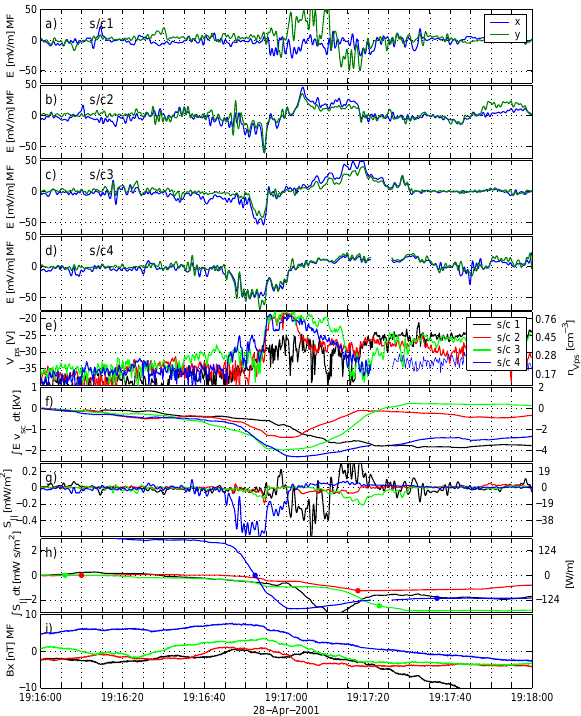
Fig. 24. Cluster overview plot from all four s/c from auroral arc crossing. (a–d) Electric field in mean field coordinates; x is pole- ward and y is eastward. (e) Probe to spacecraft potential and de- rived density estimate. (f) Integrated potential, the labels on the right show values if the arc motion is taken into account. (g) Field- aligned Poynting flux calculated from total E and dB. (h) Integrated Poynting flux; it is set to zero at the beginning of the interval, marked by dots, used to estimate the total integrated energy flux. For (g) and (h) labels on the right show values at the ionosphere. (i) Poleward component of dB in field-aligned coordinates. (From Vaivads et al.,